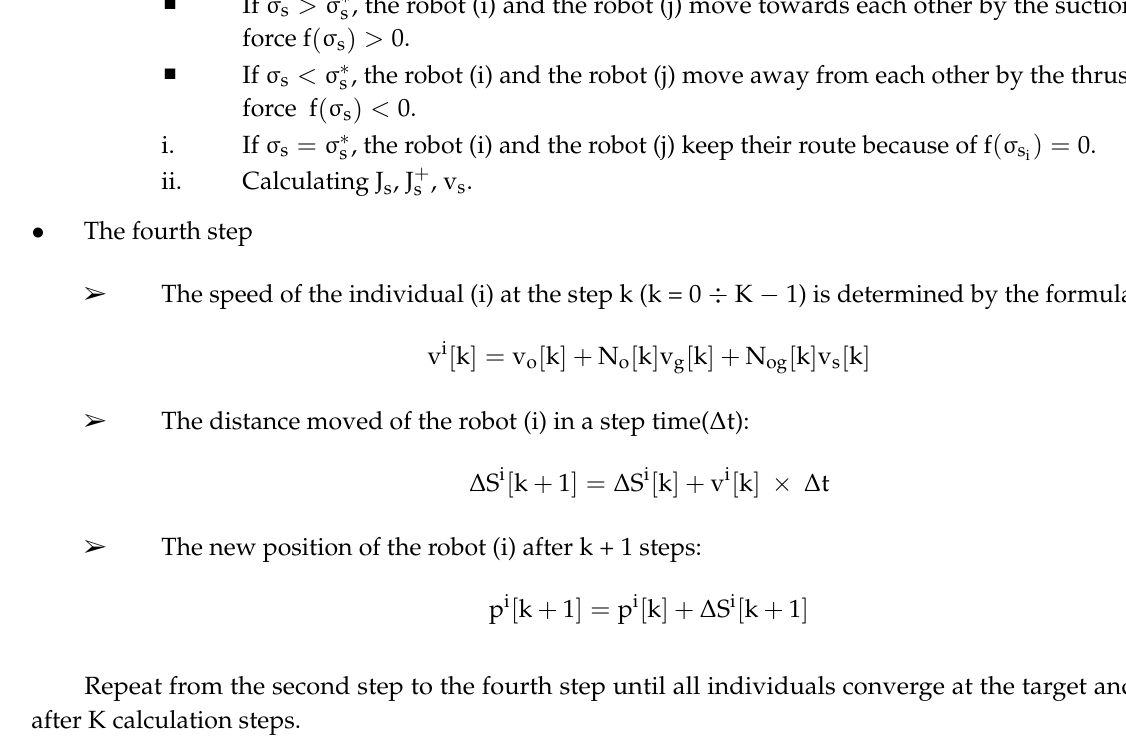
Table 1. The parameters in certain cases.